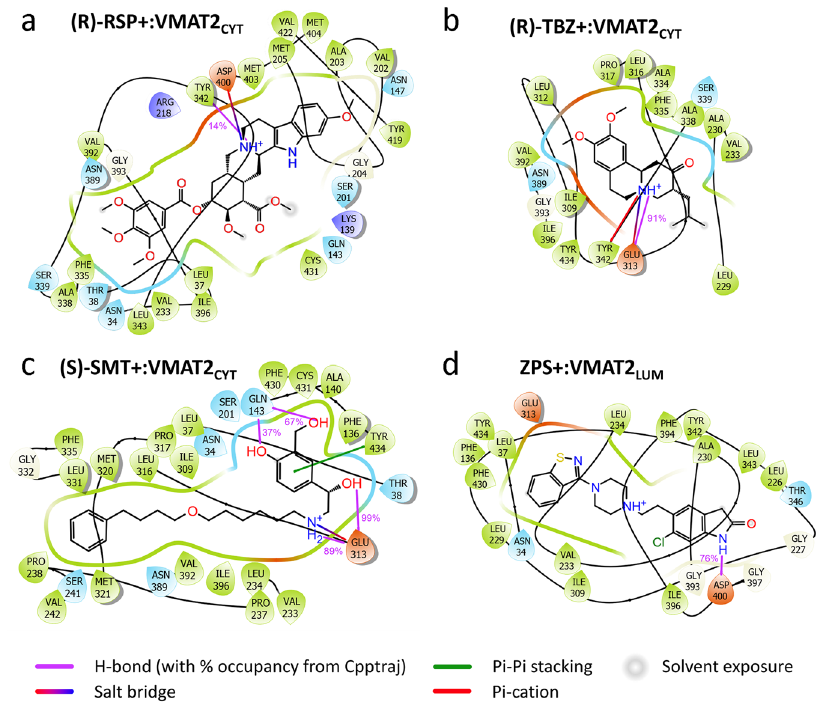
Fig. 5 Representative ligand:VMAT2 binding modes from MD simulations. a (R)-RSP + :VMAT2 CYT , b (R)-TBZ + :VMAT2 CYT , c (S)-SMT + :VMAT2 CYT and d ZPS + :VMAT2 LUM provide the representative binding modes from the stable, last 200 ns portions of the ligand:VMAT2 simulations, as 2D interaction diagrams displaying the binding pockets de fi ned by the VMAT2 residues within 4 Å of the ligand. The representative structure in each case was extracted as the centroid of the largest cluster following a clustering in CPPTRAJ based on the ligand position in the already RMSD- fi tted protein. The 2D ligand interaction diagrams were generated using Schrödinger Maestro, and hydrogen bond occupancies calculated from the simulations using CPPTRAJ were added to the